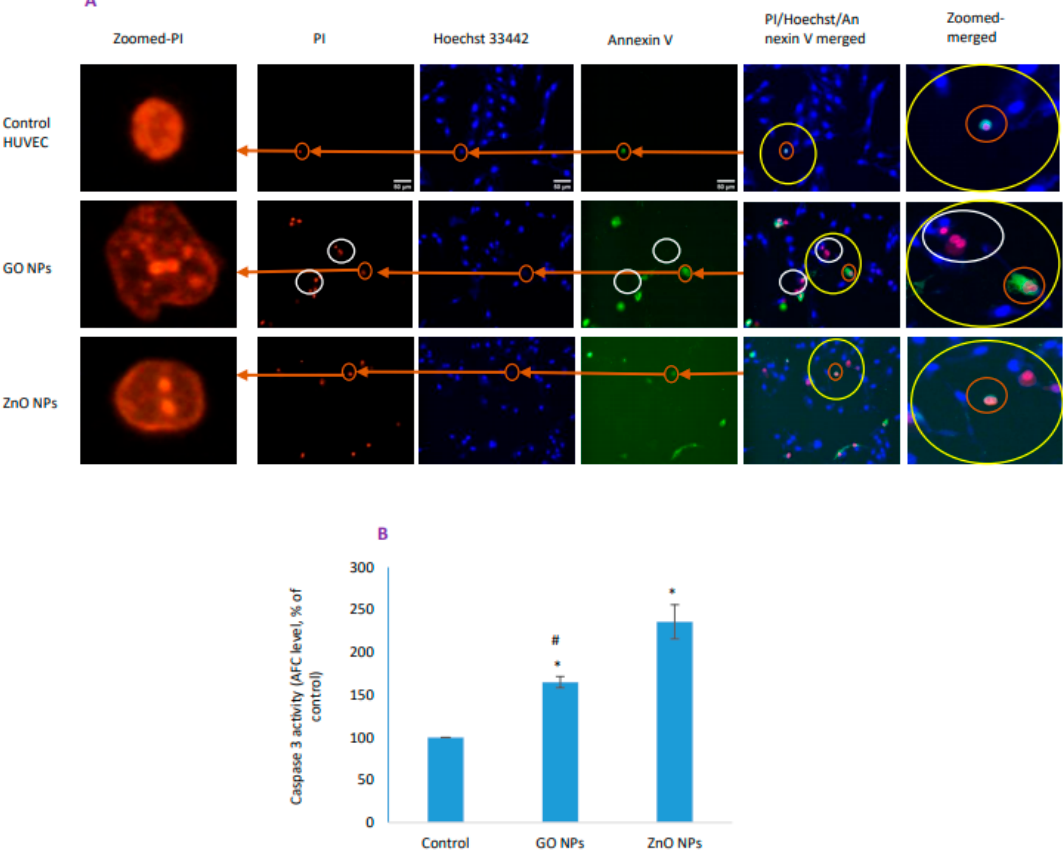
Figure 6. HUVEC cells treated with toxic concentrations of NPs of GO and ZnO for 48 h and apoptosis/necrosis was determined by ( A ) triple-staining and ( B ) caspase-3 activity. Cells were stained with Hoechst 33442 (blue color) that stains nucleus of live or dead cell, PI (red color) that stains nucleus of only dead or dying cell and annexinV (green color) that preferentially stain apoptotic cells. Zoomed images (left) represent equal areas carved out from each of PI images to observe morphology of nucleus in greater detail whereas zoomed out images (right) are carved out from each merged image for a better visualization representing the area equal to yellow circles. Scale bar represents 50 µm (20× objective). * Statistically significant difference than the controls ( p < 0.05). #— Significantly low caspase-3 activity due to GO NPs compared to ZnO NPs ( p < 0.05).